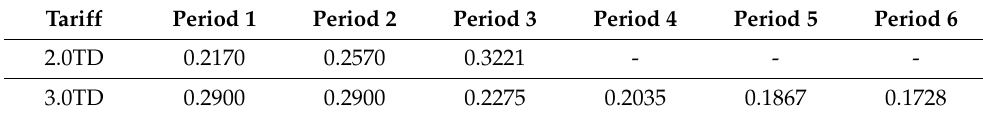
Table 3. Electricity prices ( € /kWh) for each tariff period.